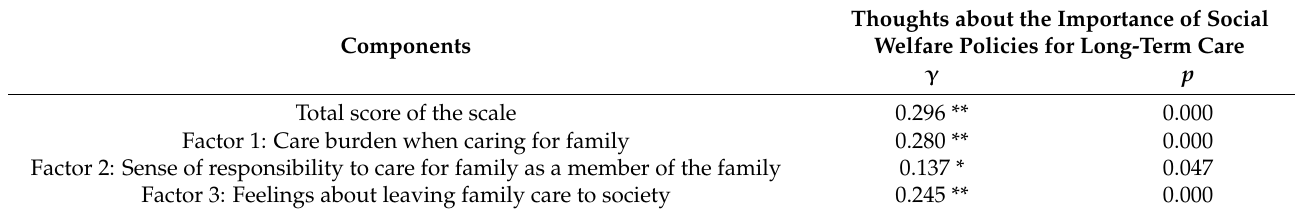
Table 4. Criterion validity of the awareness of long-term care socialization.